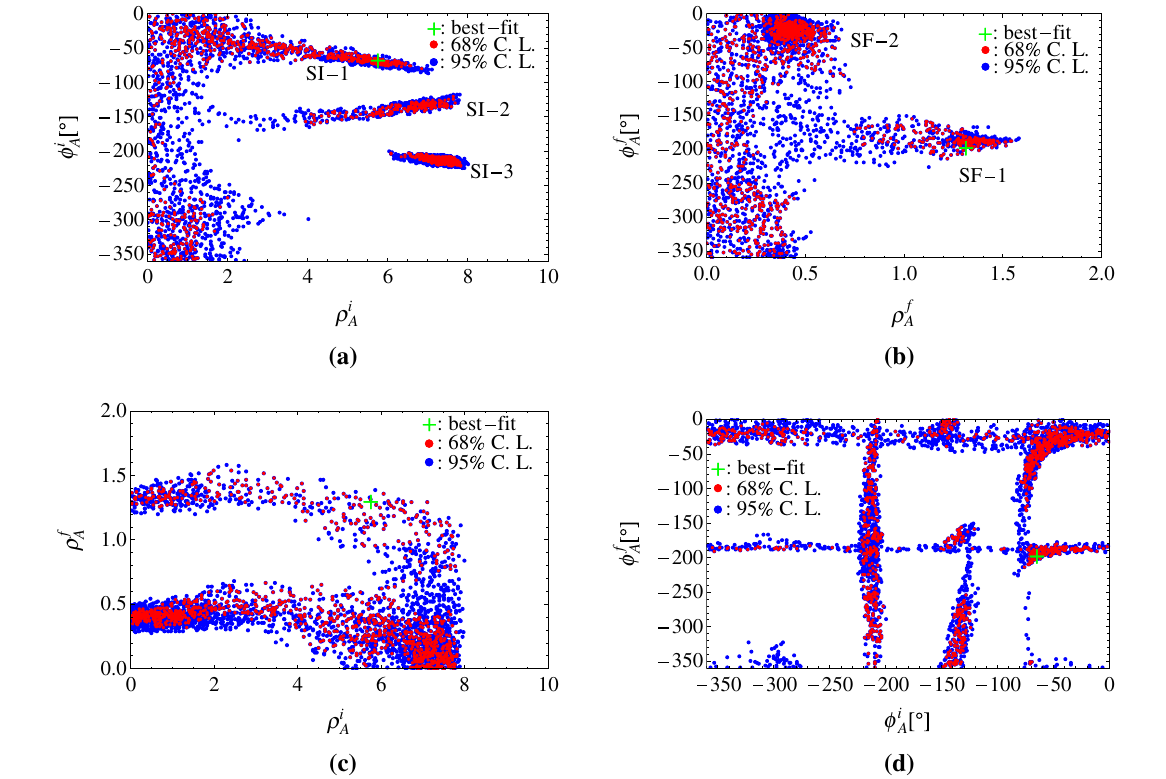
, f ,φ i , f ) ( a , b ) at 68% C.L. and 95% A A